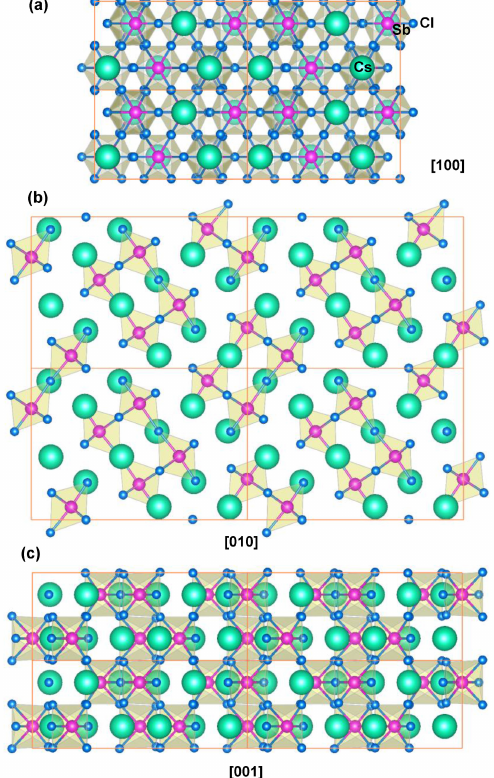
Figure 32: Structural models of β -Cs 3 Sb 2 Cl 9 with 1-dimensional perovskite structures, observed along (a) [100], (b) [010], and (c)